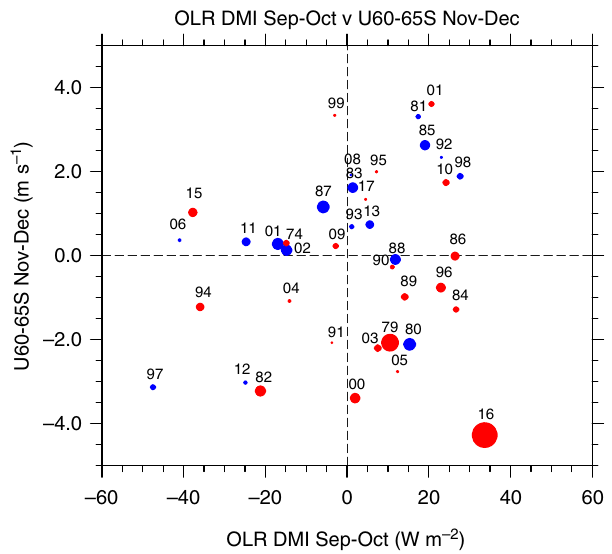
Fig. 5 Scatter plot of OLR-DMI in Sep – Oct and U 60 – 65S in Nov – Dec during 1979 – 2017. The data used here are the same as shown in Fig. 1e, f. Each dot is sized and coloured according to magnitude and sign of the SIE change mean; red for SIE decrease and blue for SIE increase). The dot sizes are proportional to the magnitude of the SIE change. Year is shown by the last two digits above each data point. Plots were generated using the NCAR Command Language version 6.4.0